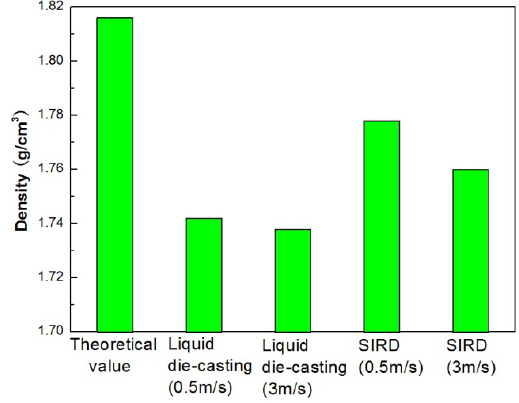
Figure 14. Density of AM60 alloy under different processes.